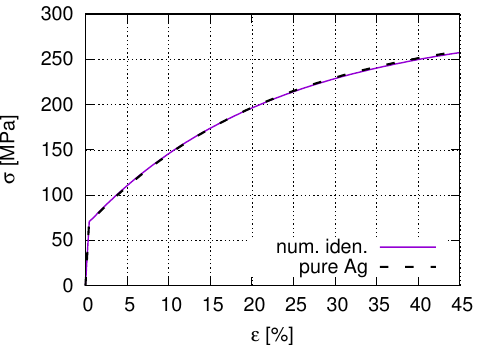
Figure 8. The experimental global flow curve and the numerical one predicted by the Taylor model for the parameter